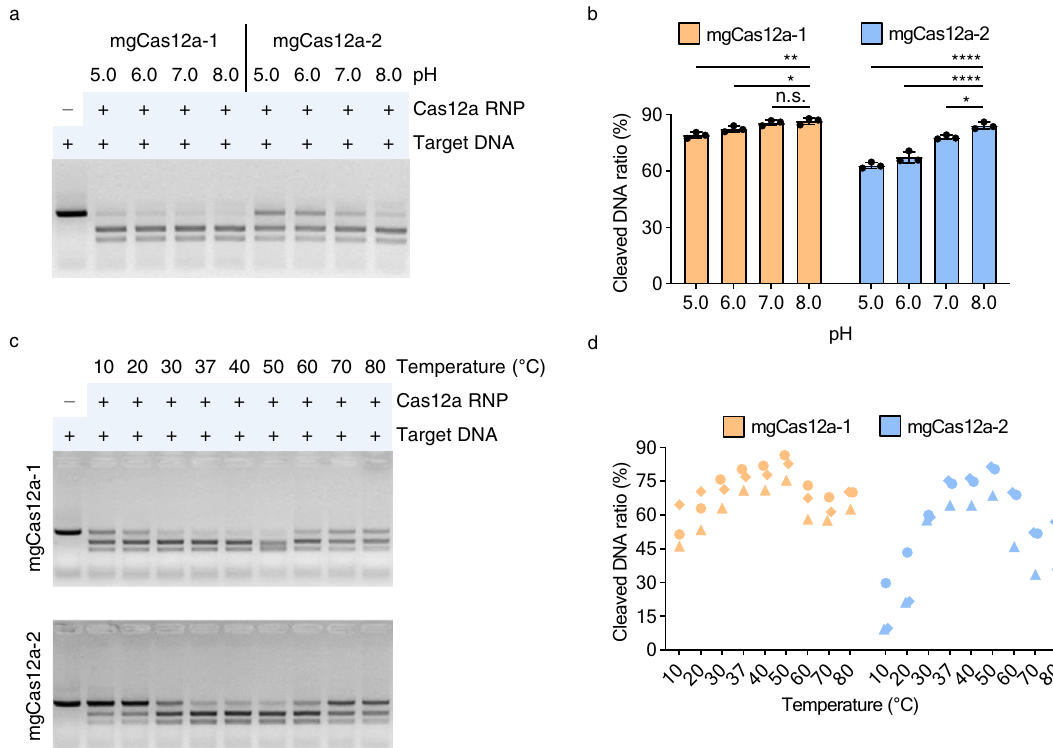
Figure 4. In vitro characterization of the mgCas12a variants in pH and temperature variations. ( a ) pH-dependent in vitro DNA cleavage activity. Cleavage assays under four different pH points from 5.0 to 8.0 were performed using target DNA #1. Original gels are presented in Supplementary Fig. 6. ( b ) The cleavage efficiency of mgCas12a under different pH points was measured with the assay shown in panel (A) and Supplementary Fig. 6. Error bars represent standard deviations ( n = 3). Significance was analyzed using a one- way ANOVA followed by Dunnett’s multiple comparison test (* p < 0.05; ** p < 0.01; *** p < 0.001; **** p < 0.0001; n.s. not significant). ( c ) Temperature-dependent in vitro DNA cleavage activity. Target DNA and mgCas12a RNP complex were incubated under a gradient of temperature from 10 to 80 °C for 30 min. Original gels are presented in Supplementary Fig. 7. ( d ) The temperature-dependent cleavage efficiency of mgCas12a was measured with the assay shown in panel (C) and Supplementary Fig. 7. Three different target DNAs were used. Circle: Target DNA #1; Diamond: Target DNA #2; Triangle: Target DNA #3 ( n = 1 for each target